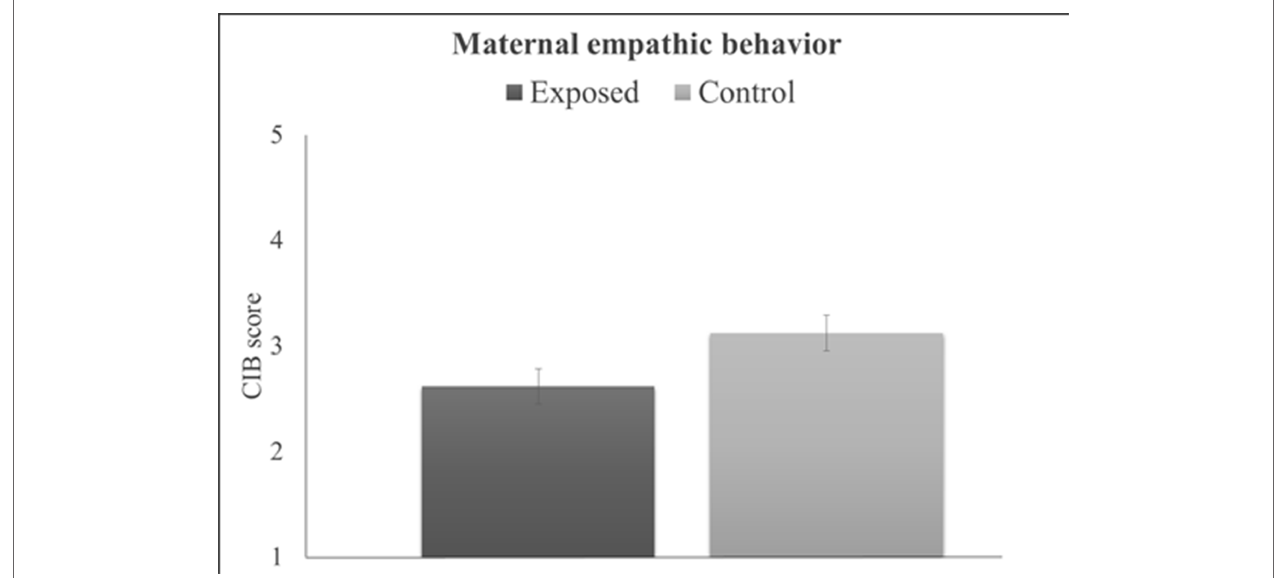
FIGURE 3 | Differences between groups in maternal empathic behavior. Error bars represent ±1 SEM.